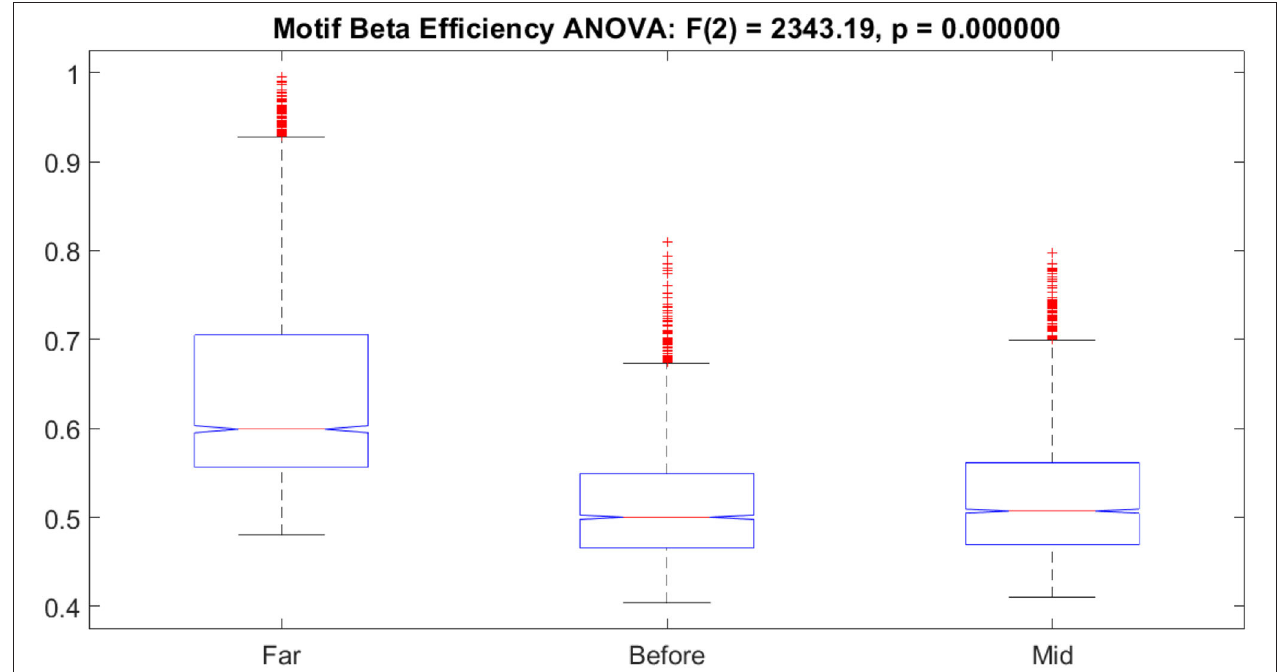
FIGURE 11 | Boxplot for global efficiency obtained with the motif method applied to the beta band and corresponding ANOVA result, comparing distributions obtained from far, before, and mid 1s EEG